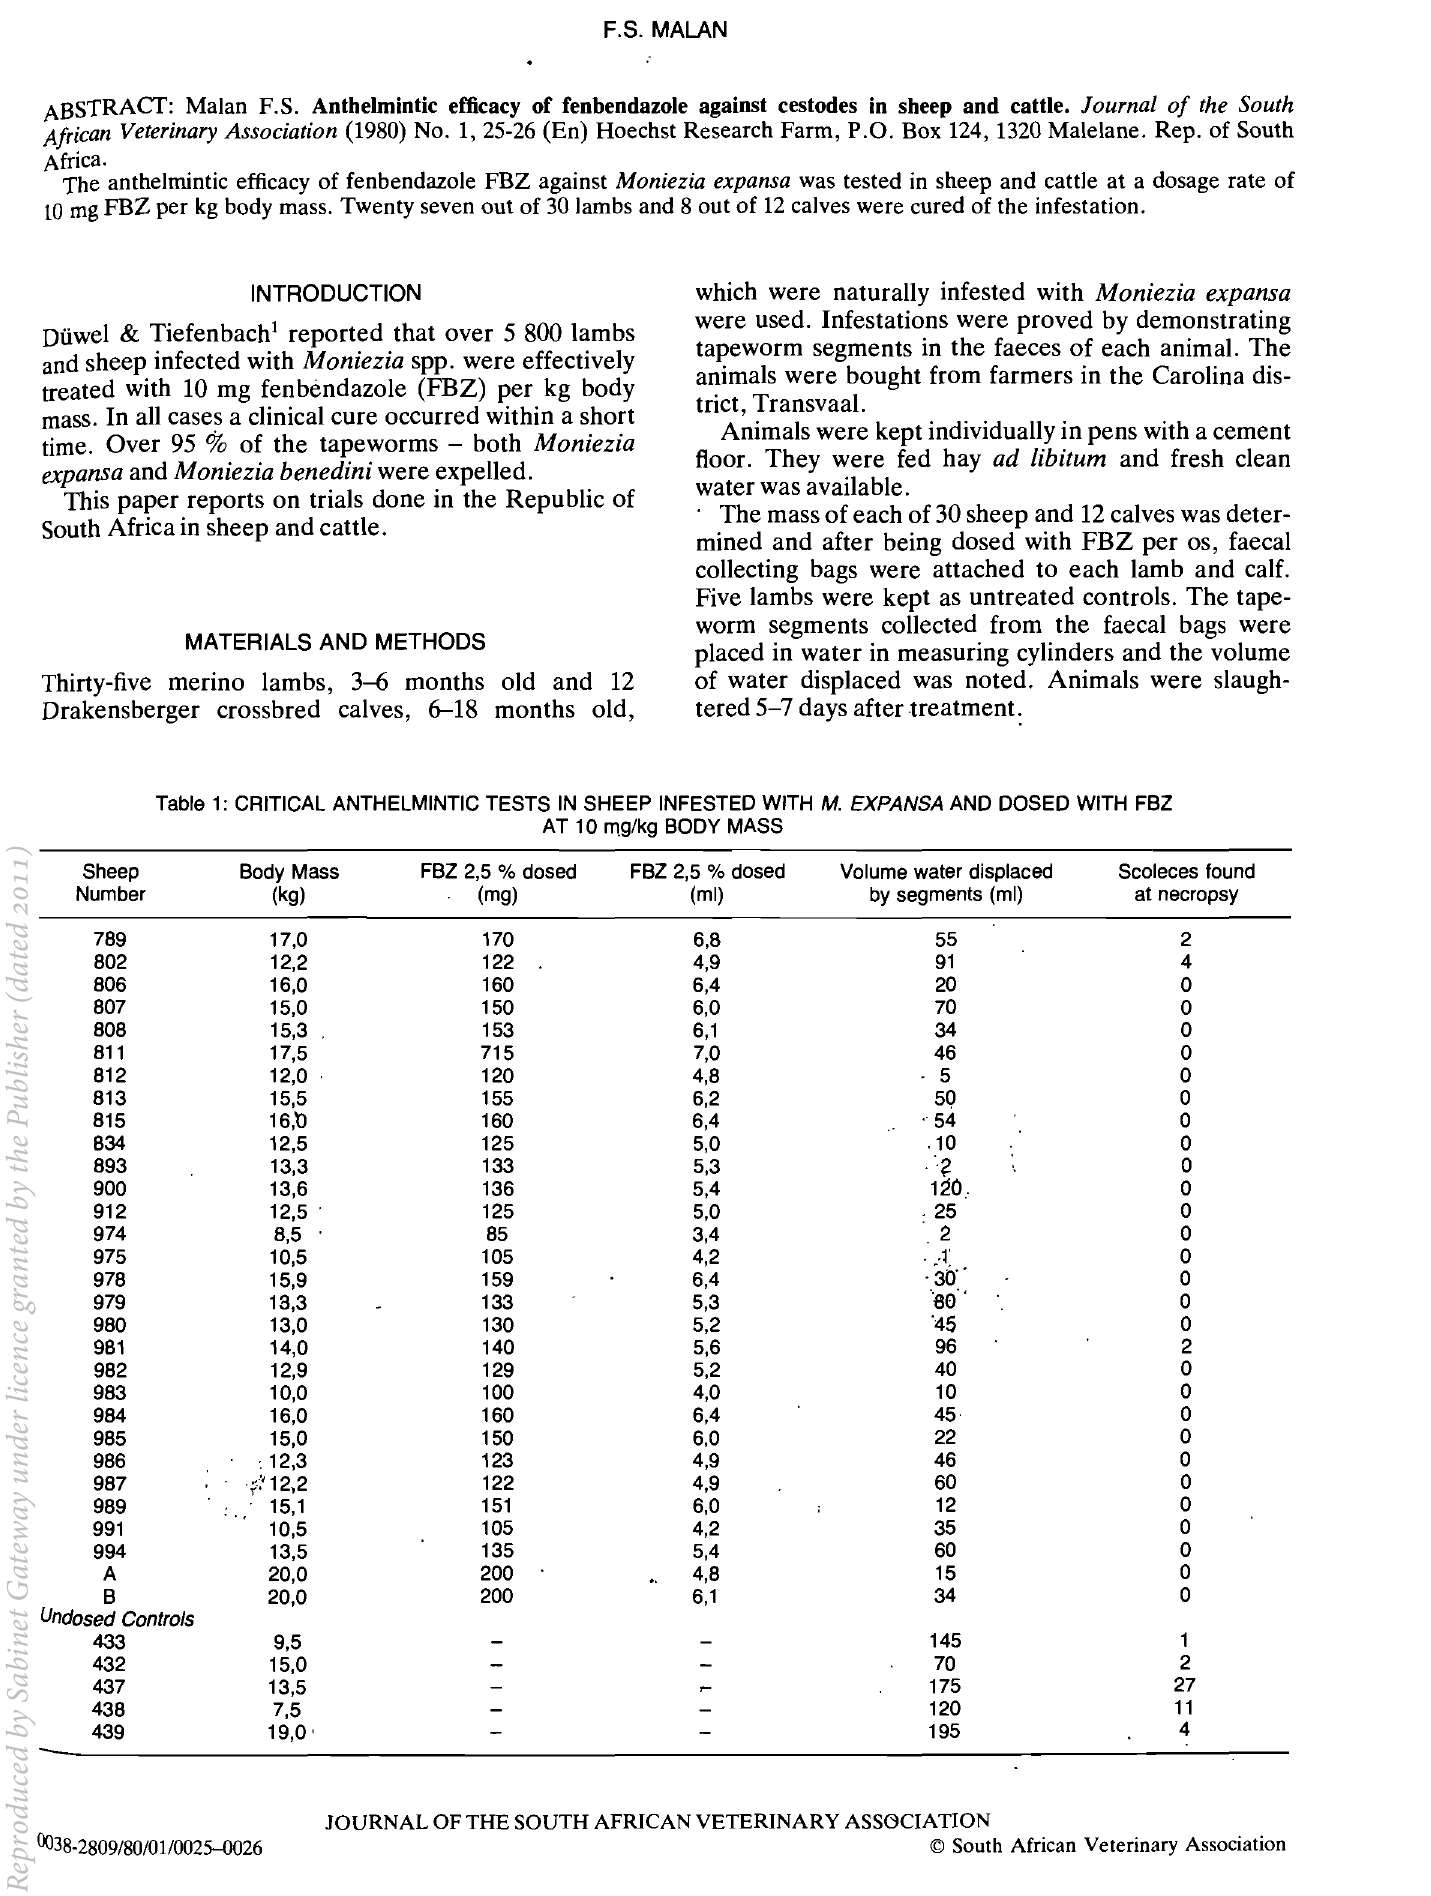
Table 1: CRITICAL ANTHELMINTIC TESTS IN SHEEP INFESTED WITH M. EXPANSA AND DOSED WITH FBZ